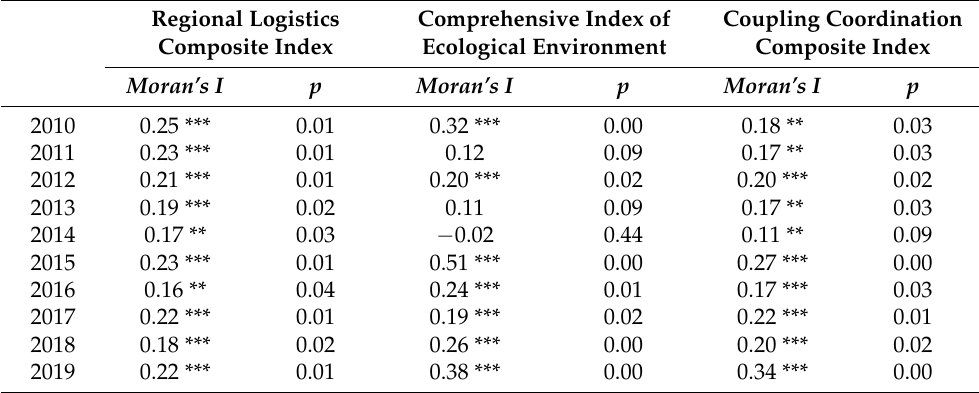
Table 9. Moran index values for each